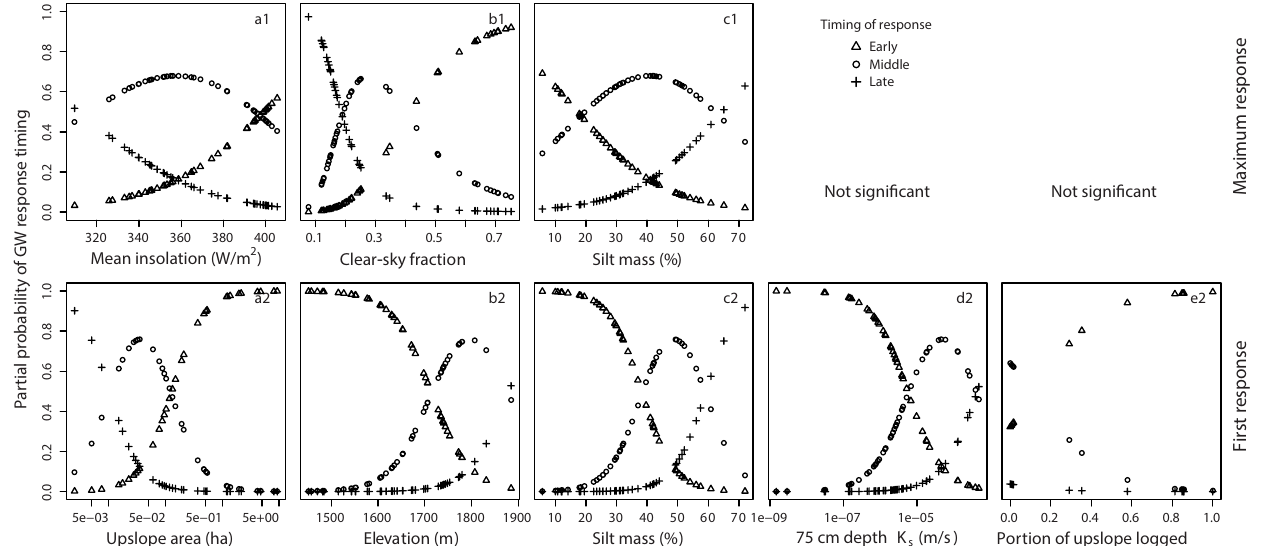
Figure 9. Partial probability of groundwater response for predictor variables in the logistic regression models. The response variables for the top and bottom rows are the timing of maximum response and the timing of first response, respectively. For calculating partial probabilities, all other predictor variables were held at their respective mean (geometric mean for K s ) values. At any value along the variable gradient, the timing of response (i.e. early, middle, or late in the melt period) with the highest probability is the most likely